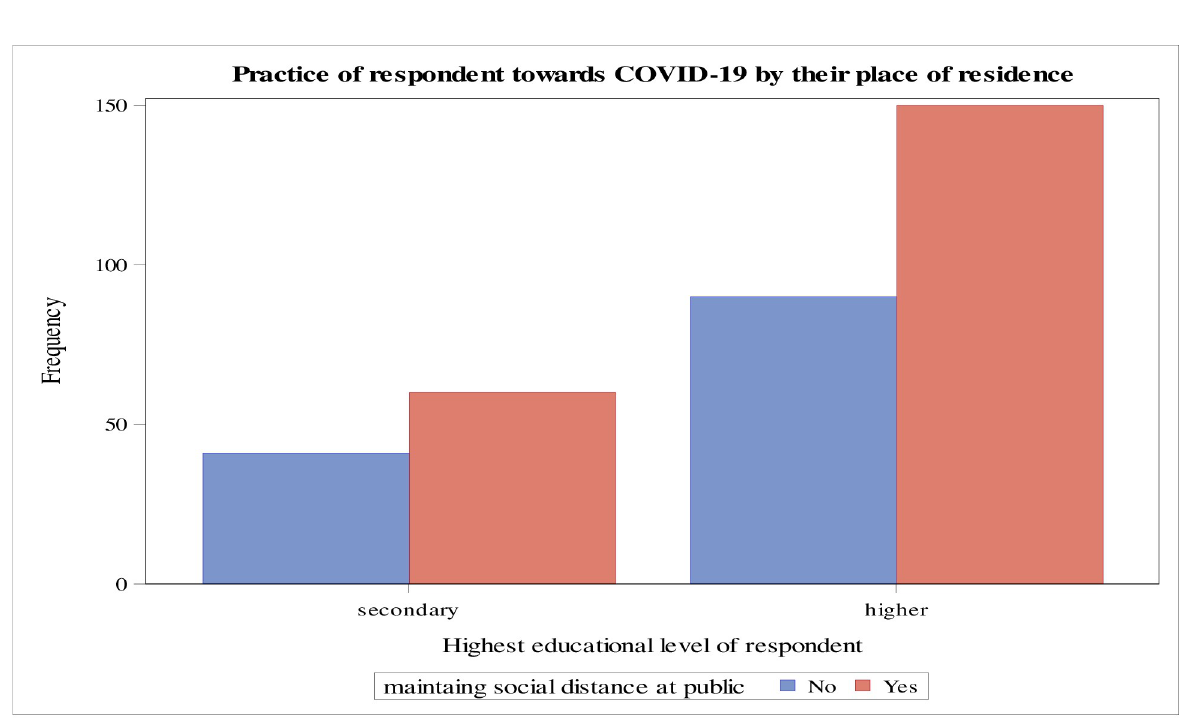
Fig 5. Respondents’ practice of maintaining social distance by their educational level, Ethiopia, May 2020.